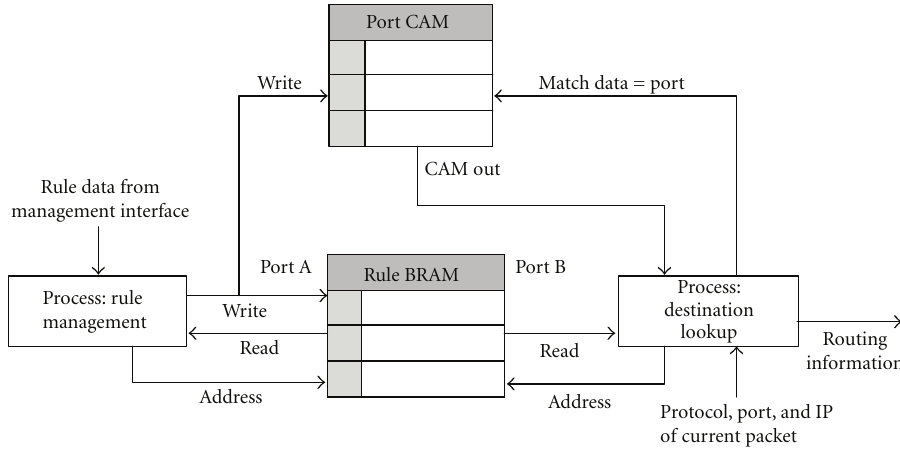
Figure 11: Layout of the destination lookup table.